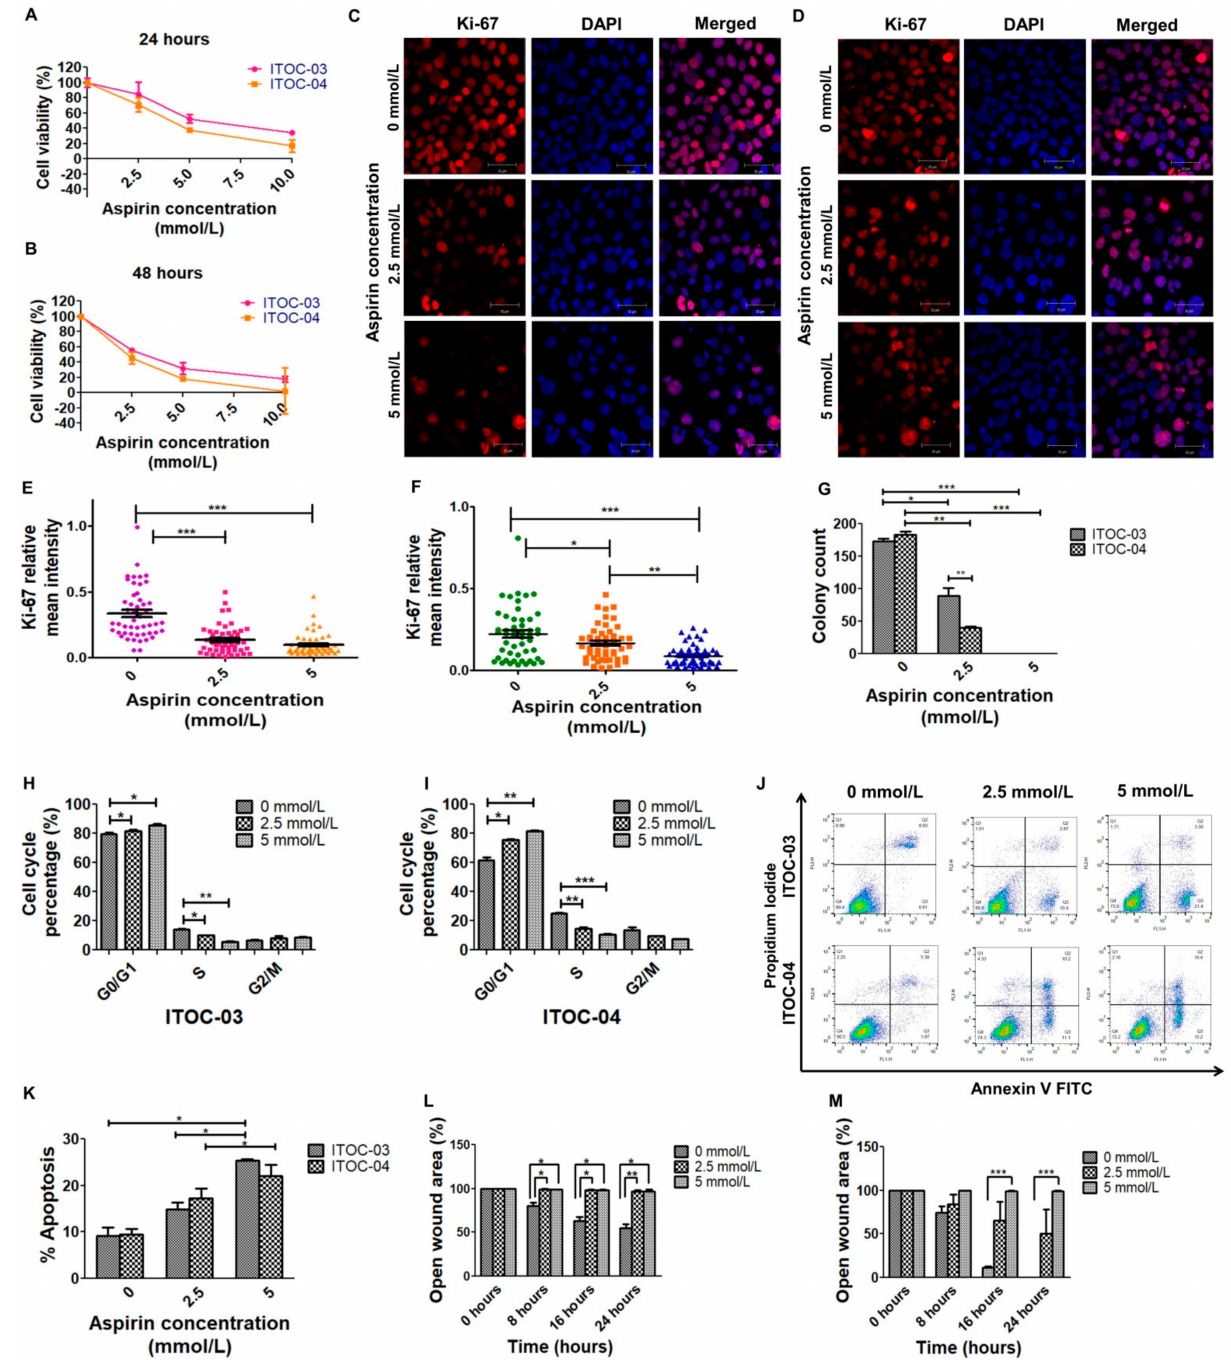
Figure 1. Aspirin inhibits cell viability, cell proliferation rate, colony formation, cell migration and induces cell cycle arrest and apoptosis in GB-SCC cells. ( A , B ) Cell viability assay showing dose- (0 mmol/L, 2.5 mmol/L, 5 mmol/L and 10 mmol/L) and time-dependent (24 h, 48 h) inhibition of ITOC-03 and ITOC-04 cells on treatment with aspirin. The error bars represent the mean ± SEM (n = 3). ( C , D ) Confocal micrographs showing dose-dependent inhibition of cell proliferation marker Ki-67 in aspirin-treated cells, scale bars—50 µ m. ( E , F ) Scatter plot representation of mean fluorescence intensity of Ki-67 marker. The mean fluorescence intensity was measured for 50 cells across five different random fields and quantified relative to the signal of DAPI. One-way ANOVA and Bonferroni post- test was used for statistical analysis, * p < 0.05, ** p < 0.01, *** p < 0.001. ( G ) Aspirin inhibits colony formation of GB-SCC cells. The error bars represent the mean ± SEM (n = 3). ( H , I ) The